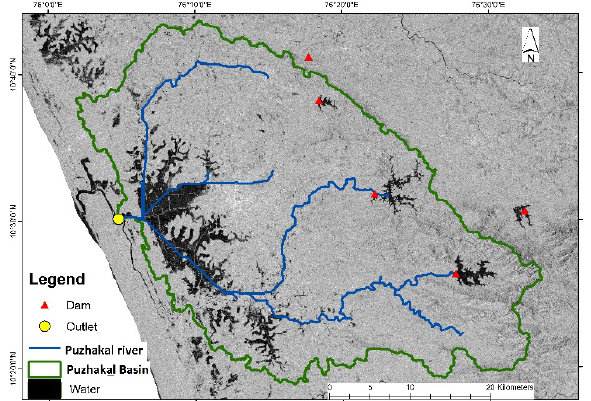
Figure 15a: Puzhakal River basin and its dam locations, the Sentinel-1 SAR data of flood time is given in background.